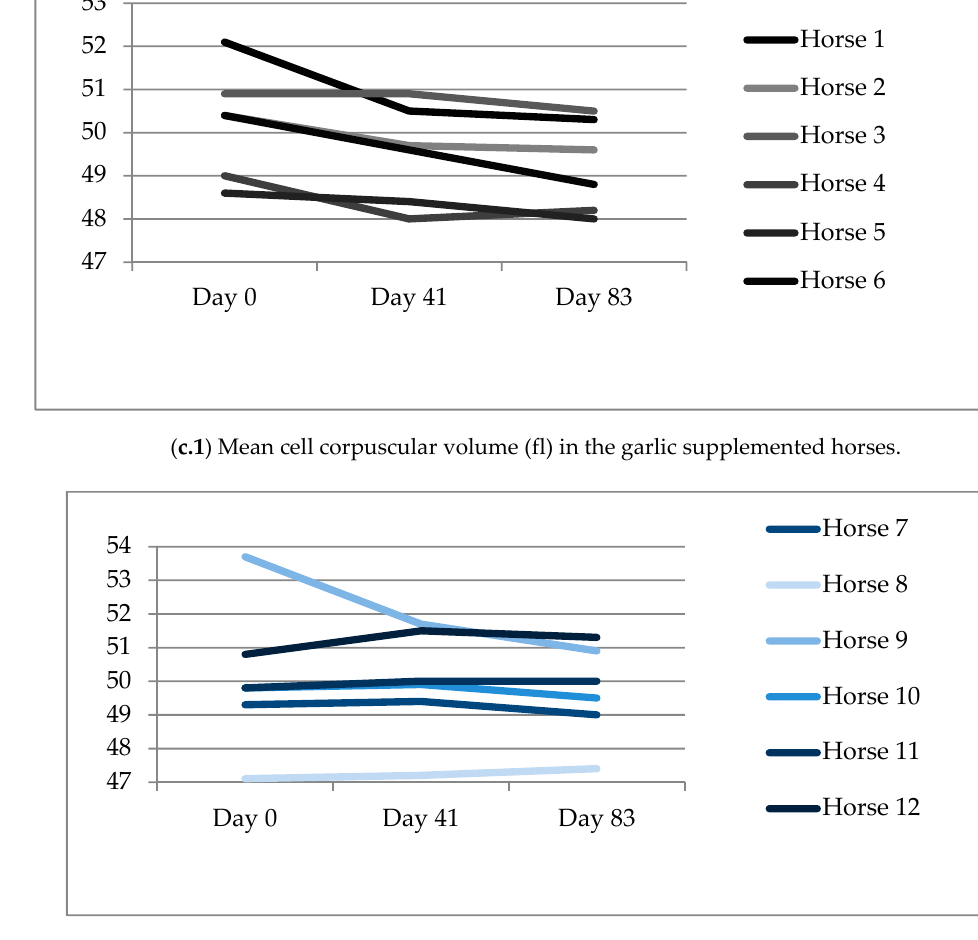
Figure 1. Hematology values of the horses in the garlic supplemented ( a.1 – c.1 ) and control ( a.2 – c.2 ) horses.